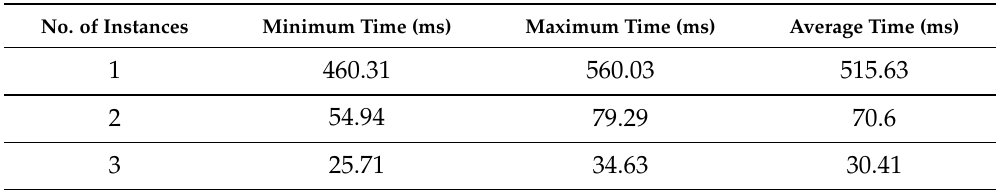
Table 4. (The results of Experiment 2.2): the latency (in milliseconds) handling concurrent requests over multiple deployed instances of the SEMi